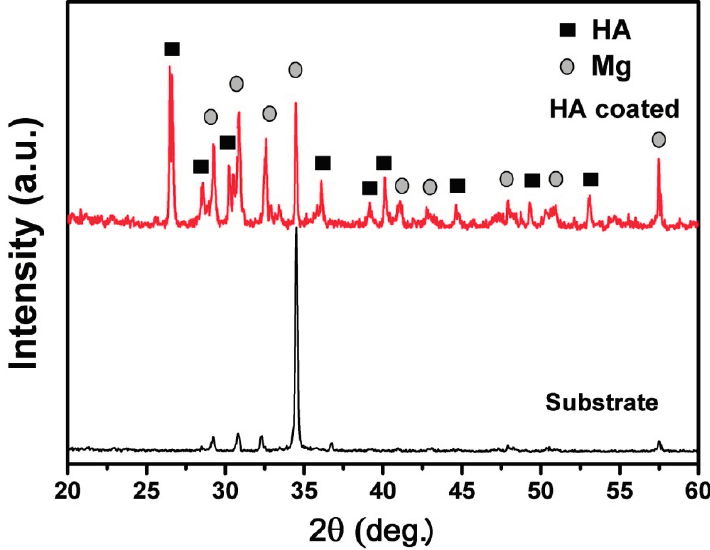
Figure 1. X-ray diffraction (XRD) patterns of uncoated and nano-whisker hydroxyapatite (nHA) coated ZK60 samples (a.u and deg. are the abbreviation of arbitrary unit and degree,